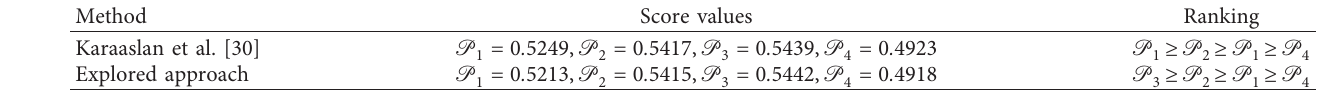
Table 2: Comparison of the explored work with existing work.